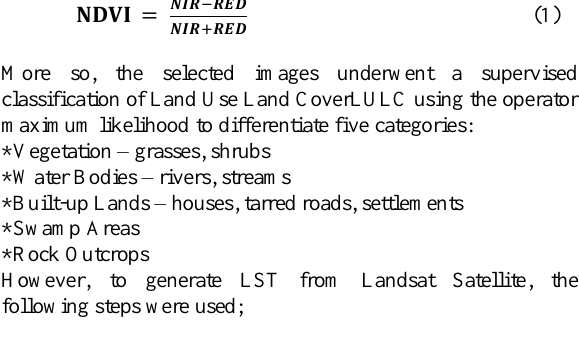
Table 3: Landsat TM and ETM+ thermal band calibration constants. Source: USGS, 2011.